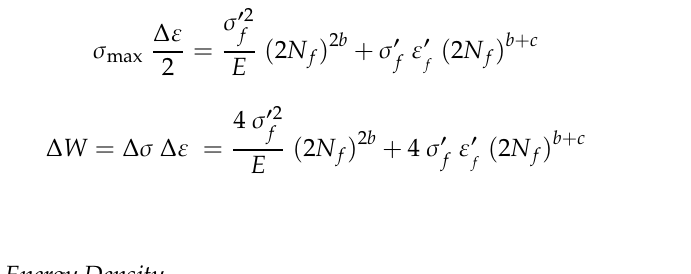
Table 2. Monotonic mechanical properties of the tested steels (Data from [6,9]).